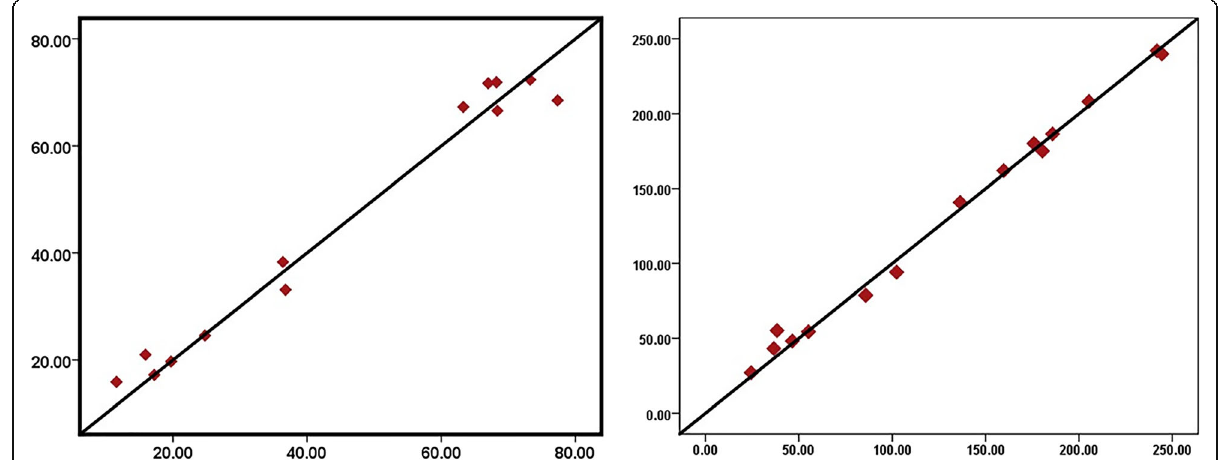
Fig. 8 Agreement plot for the first and second operators. X axis readings by the first operator, Y axis readings by the second operator, Left plot for group A, Right plot for group B